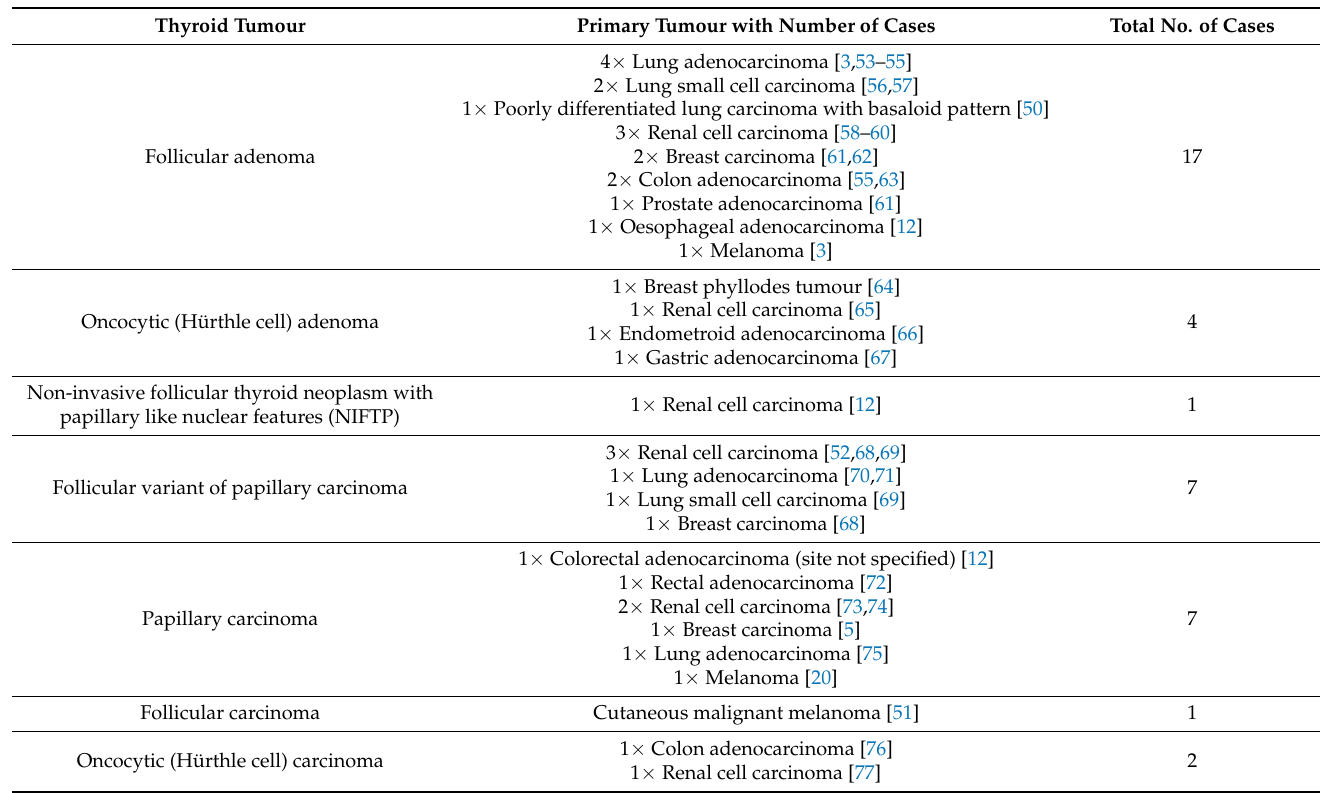
Table 3. Collision tumours of secondary cancer in the thyroid and primary thyroid neoplasm described in